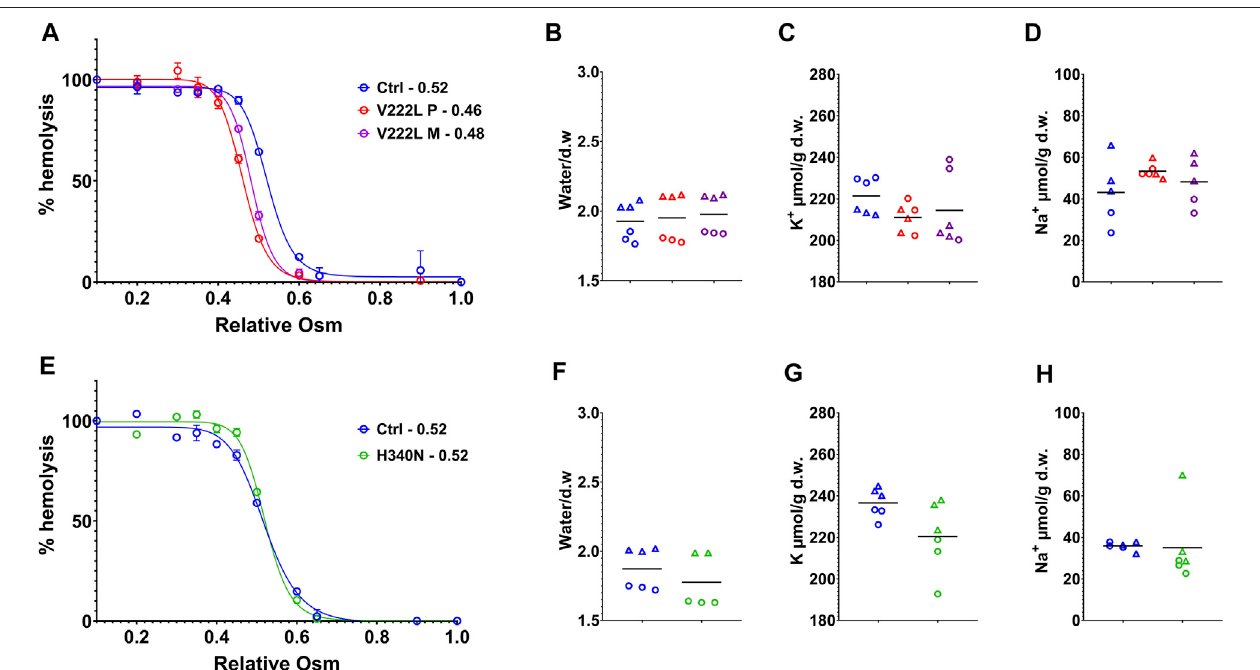
FIGURE 2 | Control vs. mutated RBC analysis. RBC analysis was made on patients and control blood collected at the same time and traveled together to the laboratory. (A,E) : Osmotic resistance analysis made on total blood represented as percentage hemolysis function of relative NaCl concentration. Data are means ± SD illustrating one experiment done in triplicate on one blood shipment for each family. (A) Control in blue, V222L proband A in red and proband A ’ s mother in purple; (E) control in blue, H340N proband B in green. (B,C,D,F,G,H) : RBC were washed in Ringer (1 mM Ca 2+ ), dried, and weighted for water content expressed in g of water/gofdryweight (B,F) ,thensolubilizedforK + (C,G) andNa + (D,H) contentmeasurementsexpressed inµmol/gofdryweight.Datashowedtheresultscomingfrom experiments performed on two blood shipments for each patient with corresponding controls (each experiment in triplicate, hence, six symbols of the same color per condition). Circles or trianglescorrespond topaired samplesin the same shipment. Fromleft to right along x axis in each plot: control(blue), proband A V222L(red), and proband A ’ s mother (purple) (B,C,D) and control (blue), proband B, and H340N (green) (F,G,H) . The bars represent the median. Statistical analyses were made with a Mann – Whitney test when comparing two conditions or Kruskal – Wallis if more than two. Neither of both gave statistical differences for any